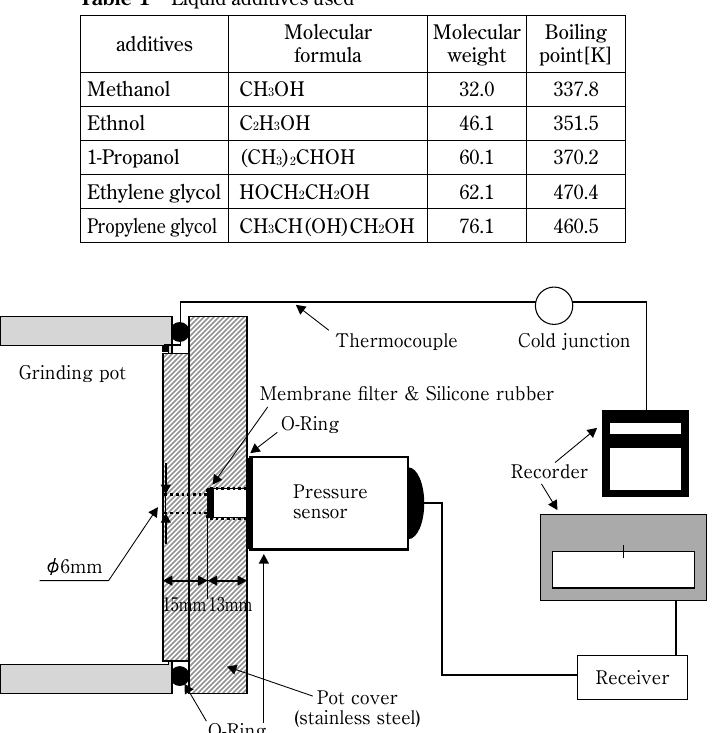
Fig. 1 Measurement method of the pressure and temperature in grinding